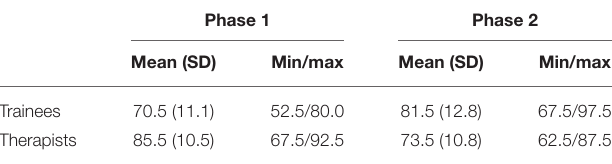
TABLE 8 | System Usability Scale (SUS). TABLE 9 | Technology Acceptance Model